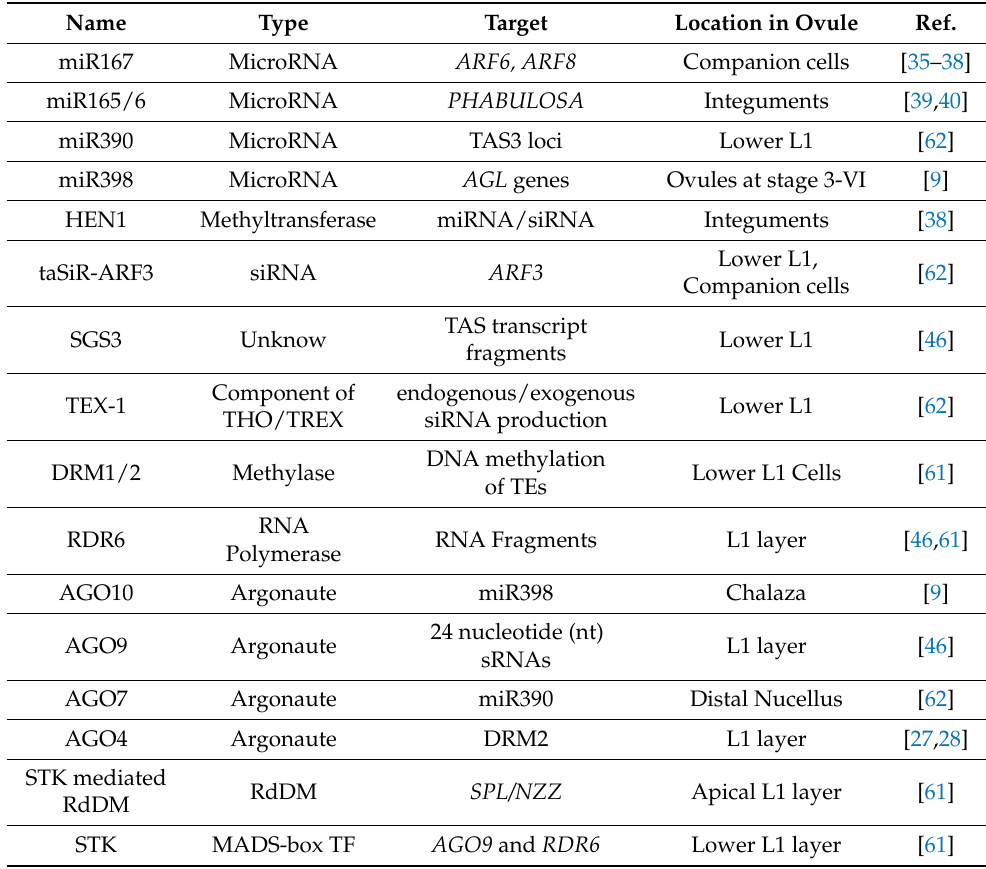
Table 1. List of sRNA pathway components involved in Arabidopsis female germline differentiation and